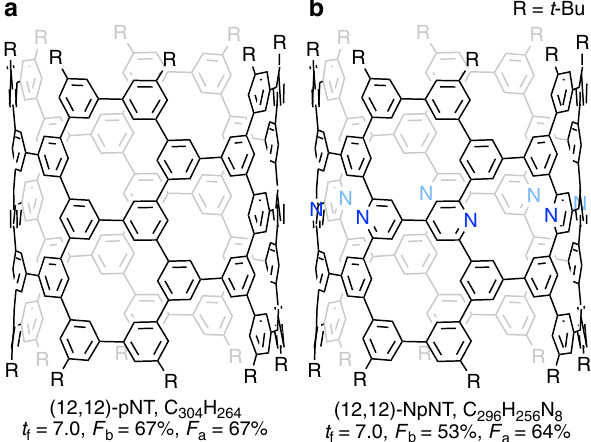
Fig. 1 Phenine nanotube molecules. a (12,12)-pNT. b Nitrogen-doped